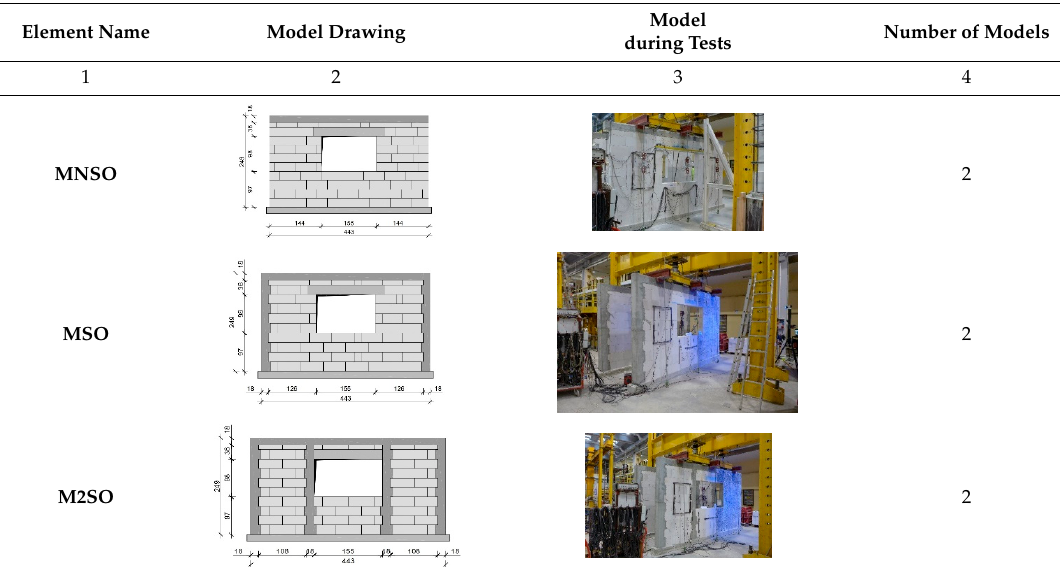
Table 2. Research programme for full-scale walls (dimensions in cm).